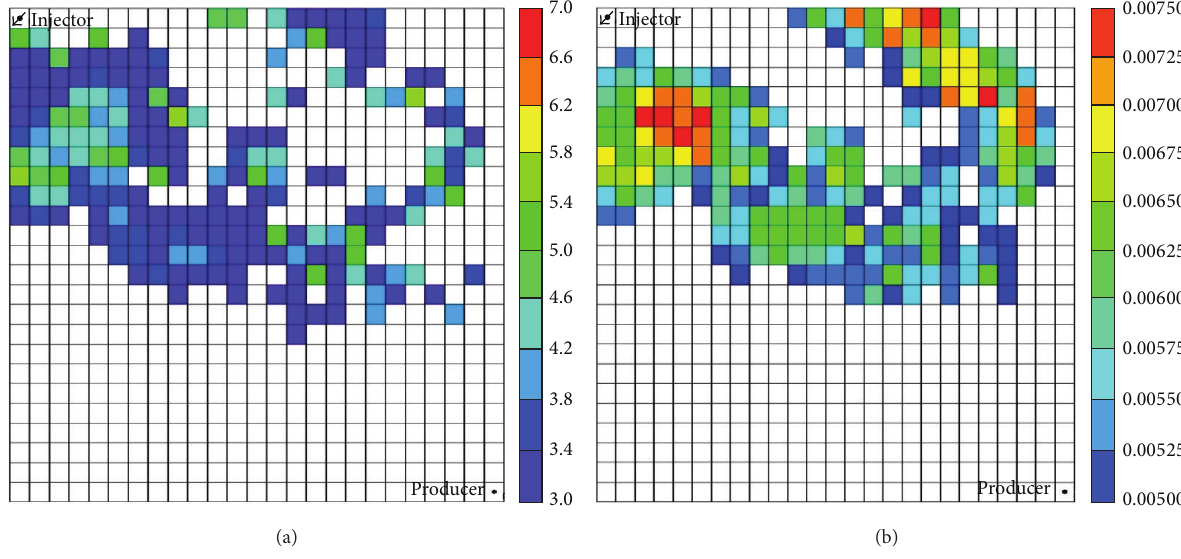
Figure9:Comparisonofdistributionbetweenpermeabilityreductionandpolymerviscosityregionscalculatedbasedontheproposedmodel: (a) RRF distribution and (b) viscosity (kg/m ⋅ s)